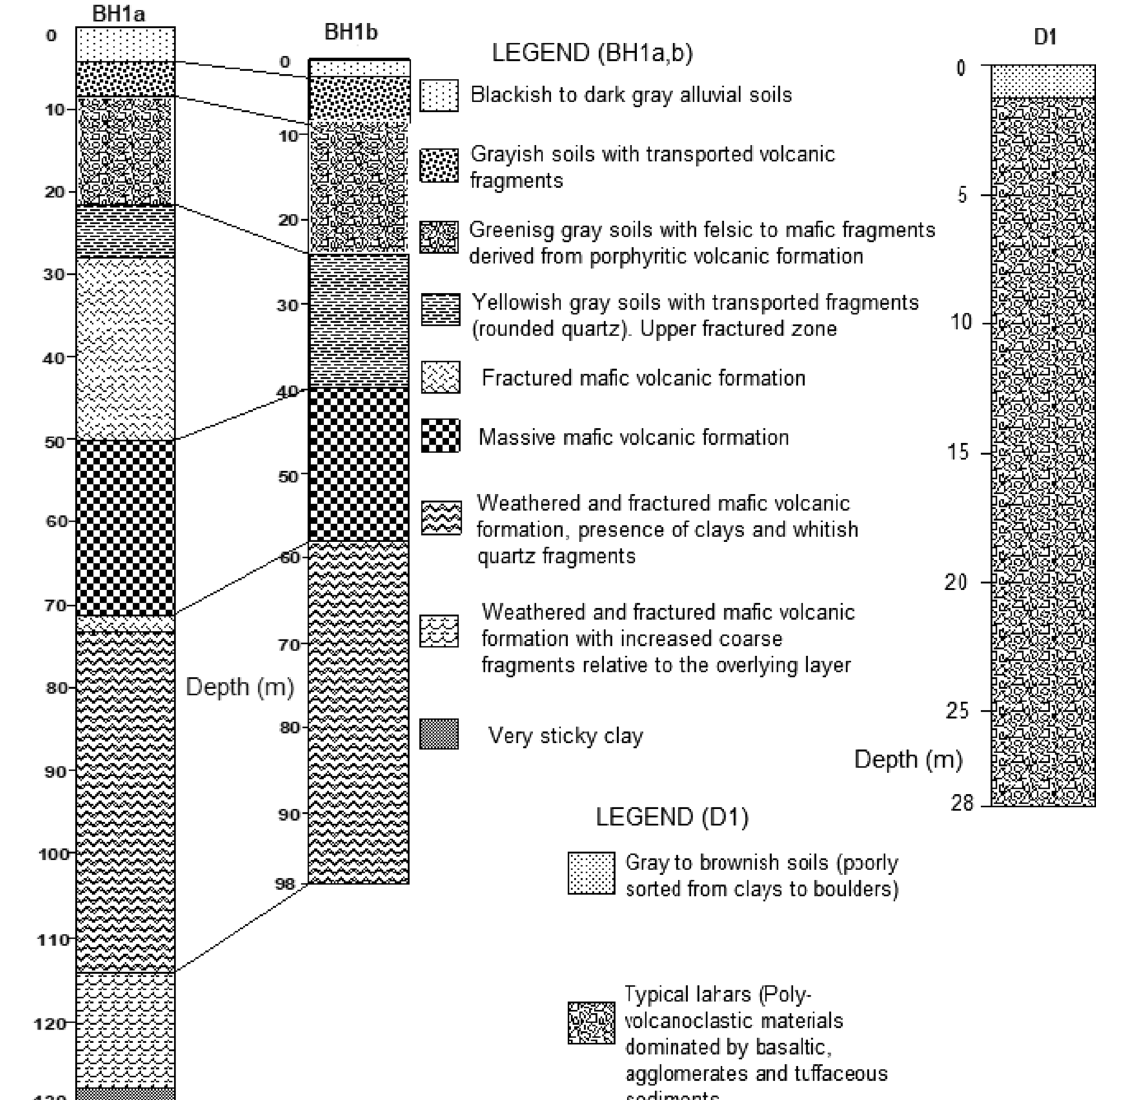
Fig. 4 Lithological logs of two boreholes BH1a, b (~ 100 m apart), represented by BH1 in Fig. 2, drilled on lahars of various age and one dug well (D1) drilled on Ngarenanyuki lahars (Fig. 2). Lithological